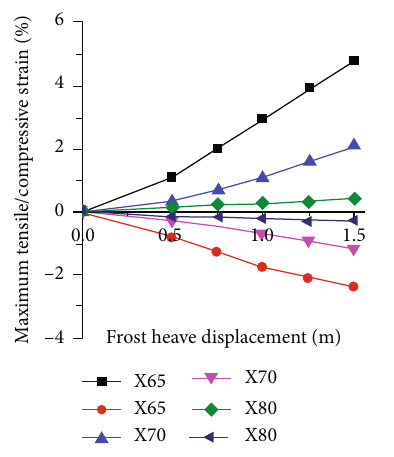
Figure 10: Relationship between maximum tensile and compressive strains and frost heave